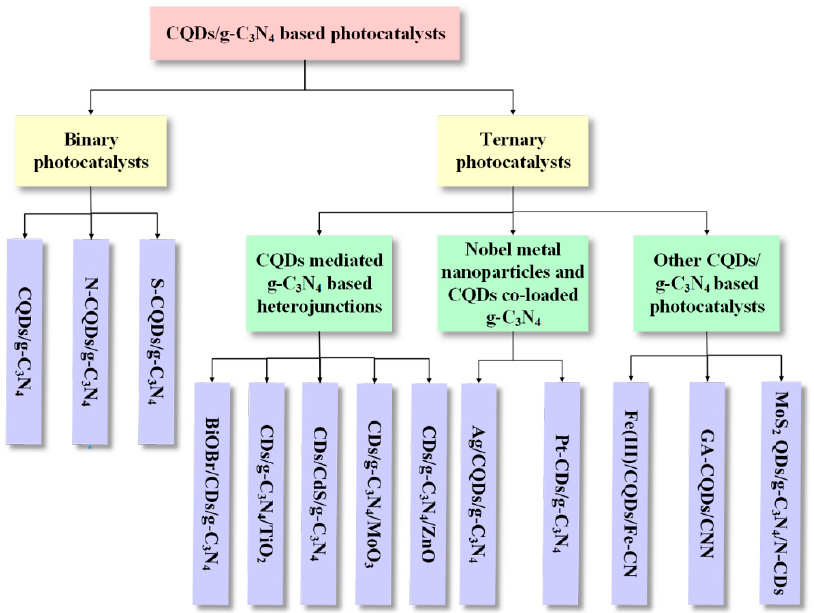
/ g-C 3 N 4 -based